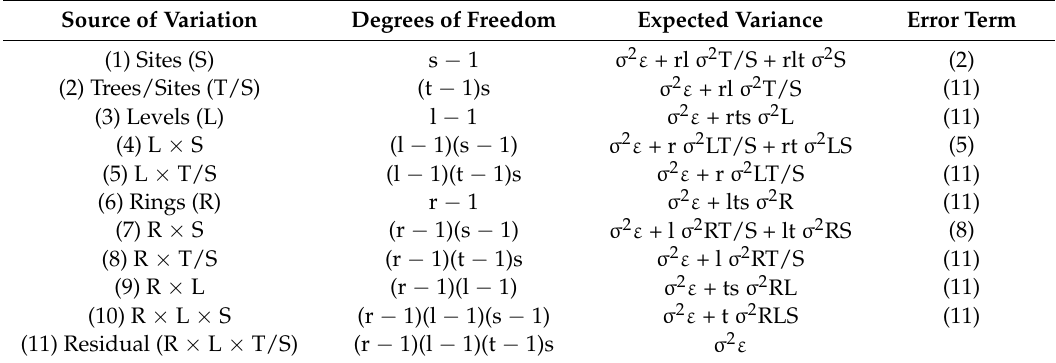
Table 2. Model used for analysis of variance for the ring width and density components. Source of Variation Degrees of Freedom Expected Variance Error Term